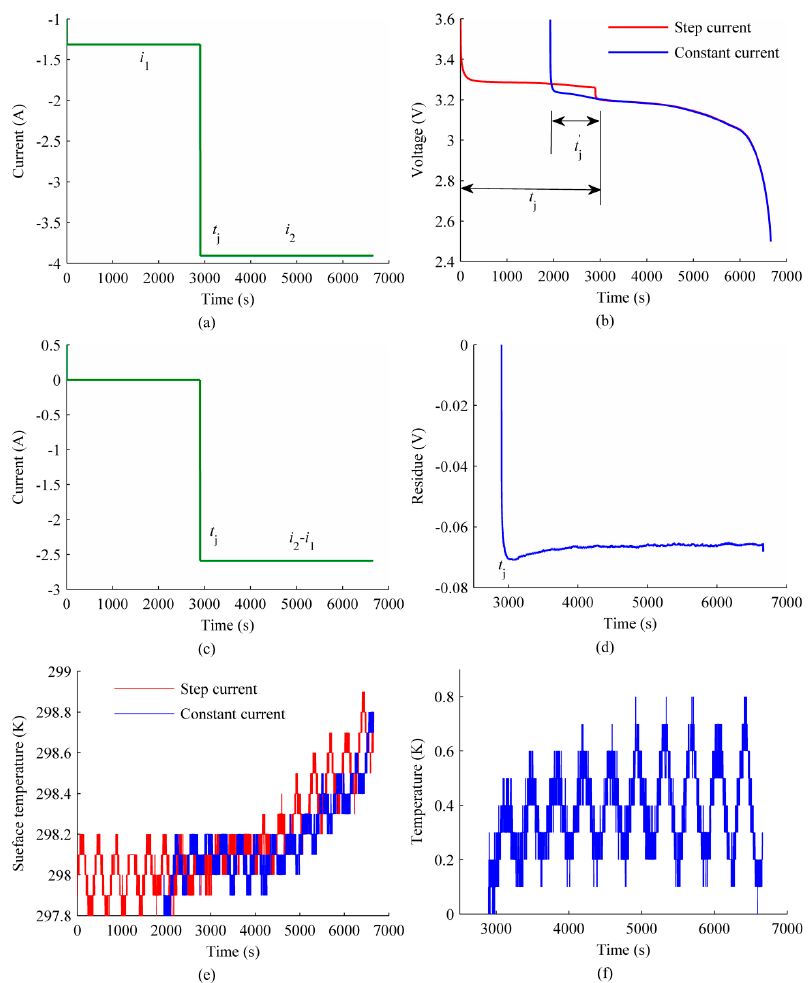
Figure 6. Test results under { i 1 = − 1.3 A, i 2 = − 3.9 A, SOC j = 79%}: ( a ) Current curve; ( b ) Terminal voltage curves; ( c ) Preprocessed current curve; ( d ) Residue voltage curve; ( e ) Surface temperature curves; ( f ) Residue temperature curve.